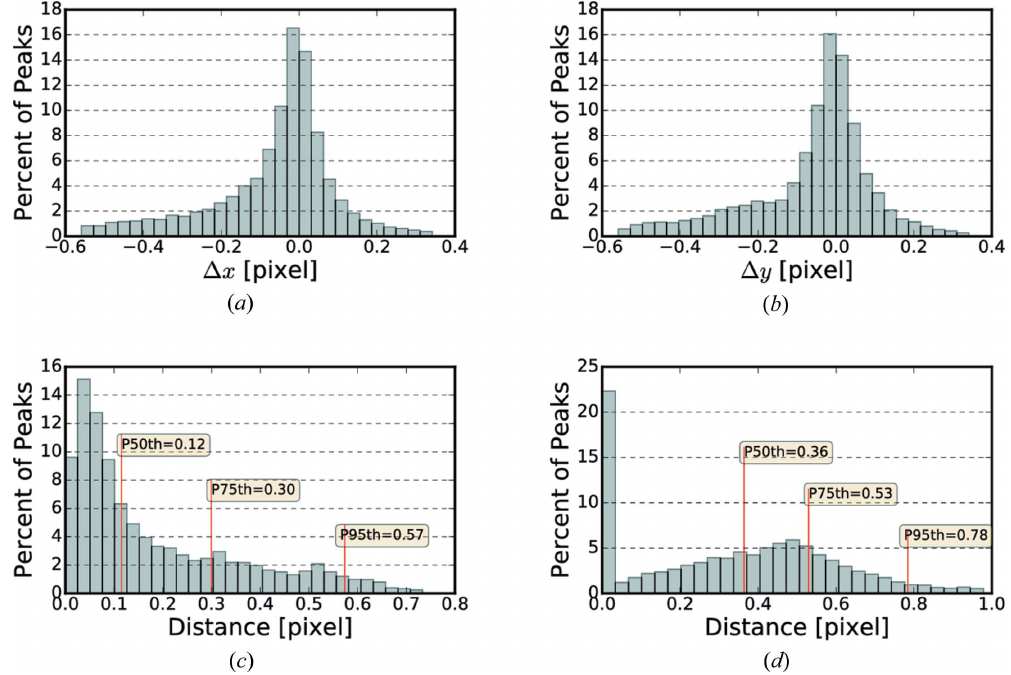
Figure 4 Distribution of difference between peak positions determined using ( a )–( c ) BraggNN or ( d ) maxima and the conventional pseudo-Voigt fit. ( a ) Difference in horizontal direction, ( b ) difference in vertical direction, ( c ) euclidean distance between peak position and ( d ) euclidean distance between peak positions determined using the maxima position of peaks and conventional pseudo-Voigt fit. P n in ( c ) and ( d ) denotes the Euclidean distance at the n th